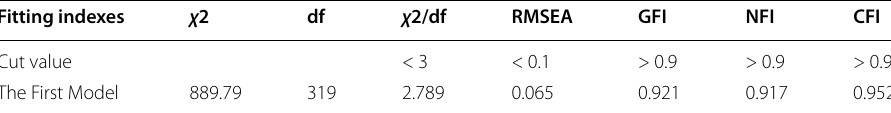
Table 3 Model fit indices Fitting indexes